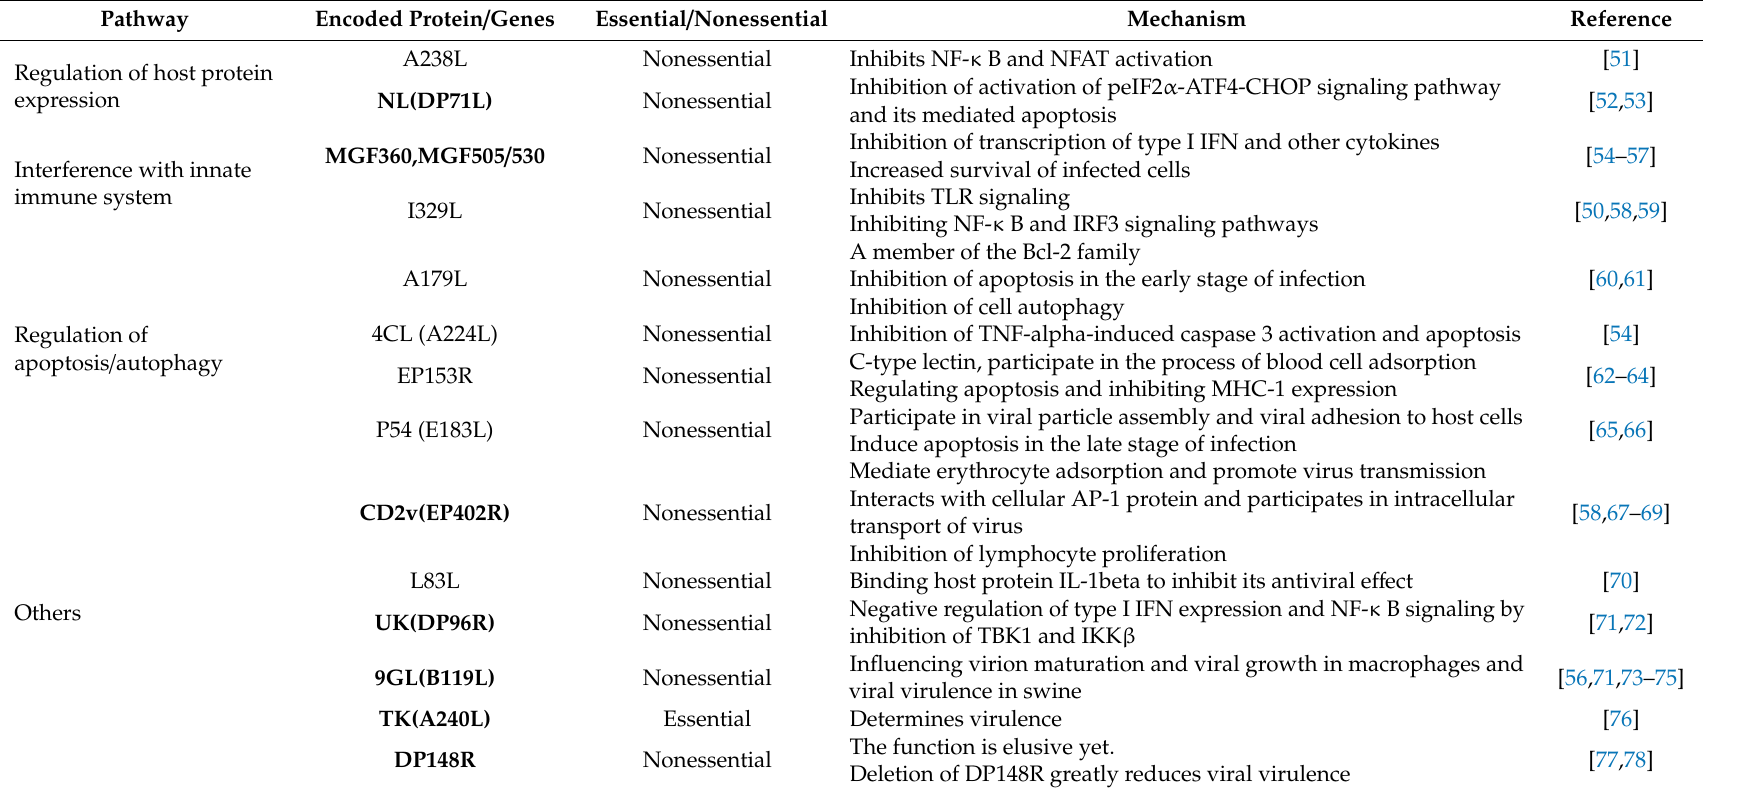
Table 2. Advances in major virulence genes / immune escape-related genes of